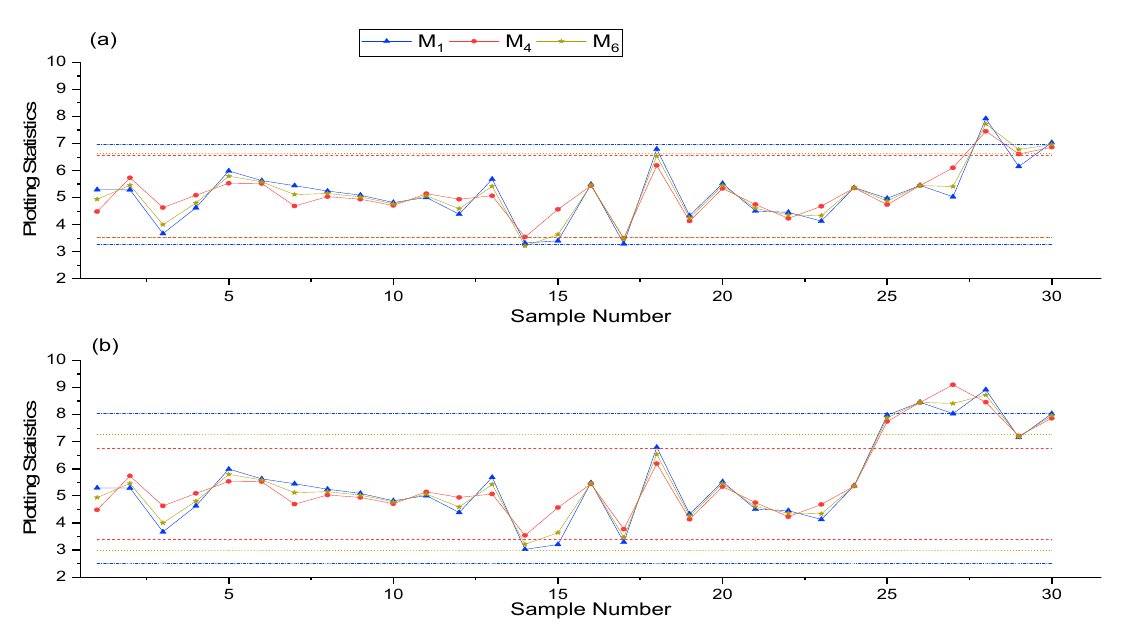
Figure 10. Graphical displays of plotting statistics corresponding to their control limits at ( a ) 𝑚 (cid:2869) = 3 and 𝛿 = 2.0 ; ( b ) 𝑚 (cid:2869) = 6 and 𝛿 = 3.0 .